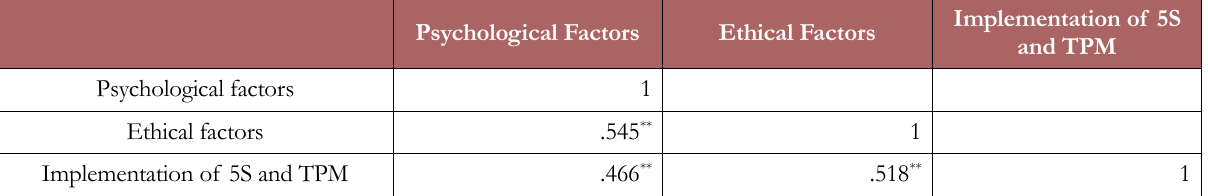
Table 5. Correlation matrix for variables of